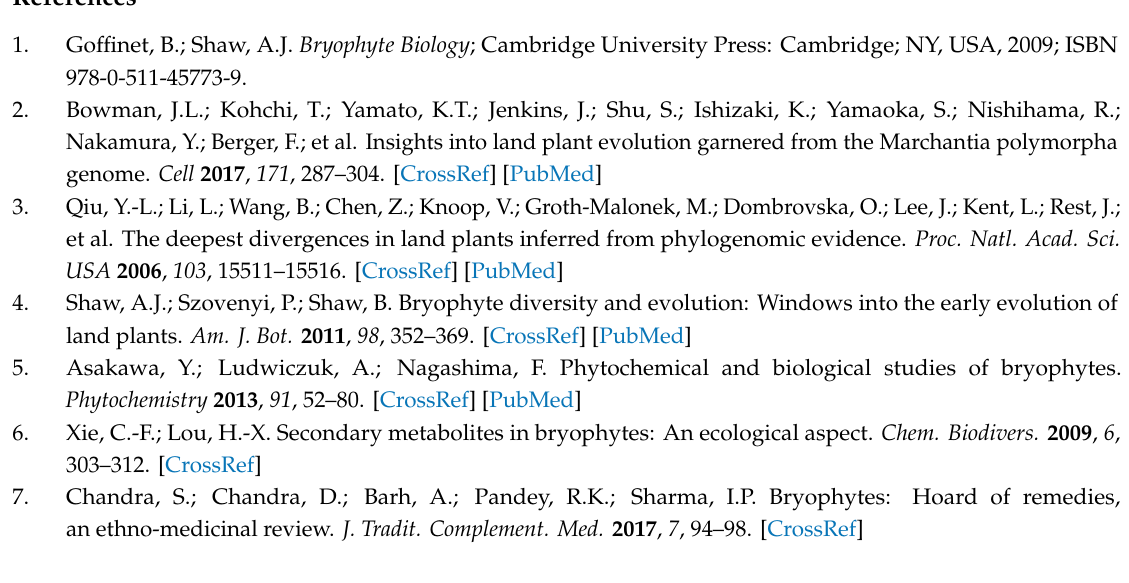
Figure S1: Comparison of three diversity indices of the bryophyte species, Figure S2: Comparison of three indices that explain the biochemical diversity of the bryophytes with regard to the four seasons, Figure S3: Variation partitioning of the study factors species and seasons of the (a) MS1 feature matrix, (b) richness of chemical entities in the classified compound classes, Figure S4: Richness of chemical entities for the di ff erent bryophyte species within the chemical classes of (a) Lipids and lipid-like molecules, (b) Fatty acids and conjugates, (c) Steroids and steroid derivatives, (d) Prenol lipids, (e) Sesquiterpenoids, (f) Lignans, neolignans and related compounds, (g) Lactones, (h) Phenylpropanoids and polyketides, (i) Cinnamic acids, (j) Stilbenes, (k) Methoxyphenols, (l) Flavonoids, (m) Flavones, (n) Flavans, (o) Flavonoid glycosides, (p) Anthocyanins, (q) Carbohydrates and carbohydrate conjugates, (r) Monosaccharides, (s) Disaccharides, (t) Glycosyl compounds, (u) Alkaloids and derivatives, (v) Amino acids, (w) Peptides, and (x) Nucleosides, nucleotides, and analogues, Figure S5: Seasonal variations in the chemical richness of the tested bryophyte species within the chemical classes of (a) Lipids and lipid-like molecules, (b) Fatty acids and conjugates, (c) Steroids and steroid derivatives, (d) Prenol lipids, (e) Sesquiterpenoids, (f) Lignans, neolignans and related compounds, (g) Lactones, (h) Phenylpropanoids and polyketides, (i) Cinnamic acids, (j) Stilbenes, (k) Methoxyphenols, (l) Flavonoids, (m) Flavones, (n) Flavans, (o) Flavonoid glycosides, (p) Anthocyanins, (q) Carbohydrates and carbohydrate conjugates, (r) Monosaccharides, (s) Disaccharides, (t) Glycosyl compounds, (u) Alkaloids and derivatives, (v) Amino acids, (w) Peptides, and (x) Nucleosides, nucleotides, and analogues, Figure S6: Seasonal variations in compound classes of the tested bryophyte species, Figure S7: Quality control as employed by the mzQuality workflow, Figure S8: Total ion chromatograms for the nine tested species grouped by seasons, Table S1: Explained seasonal variation in the compound classes by the di ff erent bryophyte species, Table S2: Influence of ecological characteristics on the matrix of compound